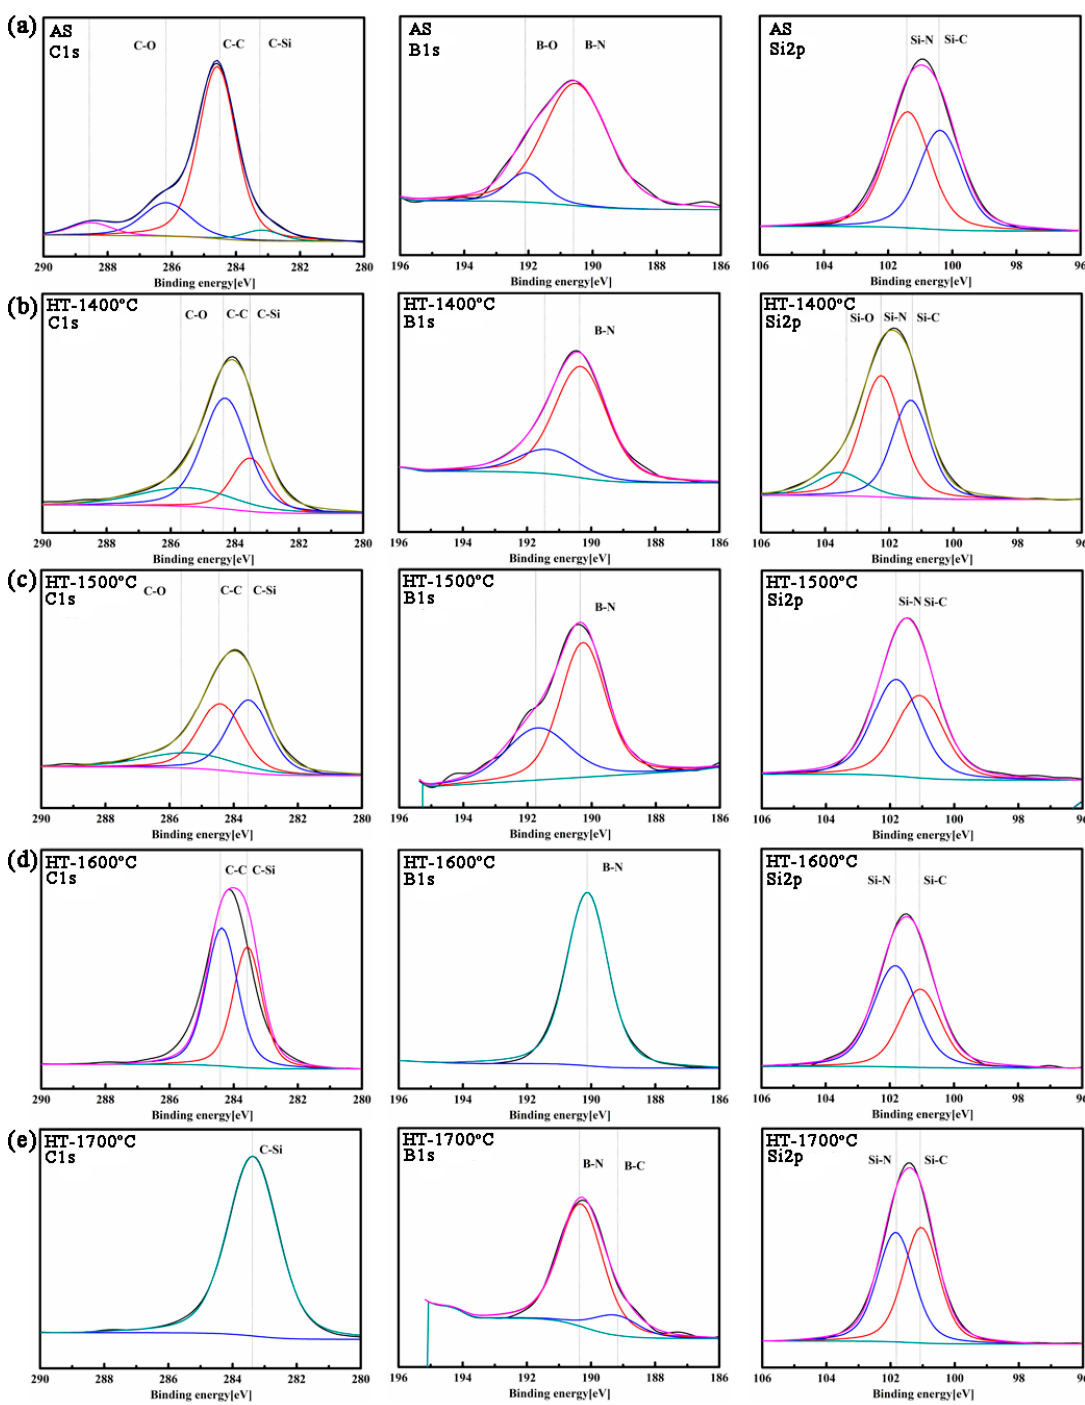
Figure 5. High-resolution XPS spectra of C1s, B1s, and Si2p core levels of SiBCN ceramics: ( a ) AS; ( b ) HT-14; ( c ) HT-15; ( d ) HT-16; and ( e ) HT-17.